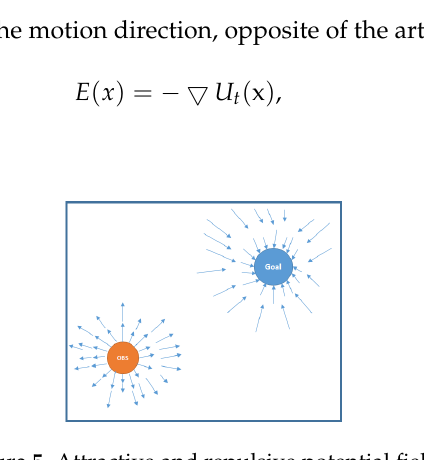
Figure 5. Attractive and repulsive potential